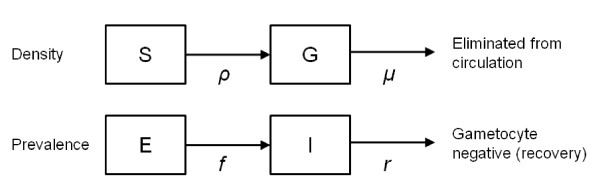
Models describing change in gametocyte density and gametocyte prevalence over time. S, sequestered gametocytes; G, circulating gametocytes; E, gametocyte-negative infected individuals (i.e. gametocytes not yet released into circulation); I, gametocyte-positive individuals; ρ rate of release of gametocytes from sequestration into the bloodstream; μ, rate of decay/removal of gametocytes; f, rate at which gametocyte-negative individuals become gametocyte-positive; r, rate at which gametocyte-positive individuals become gametocyte negative.